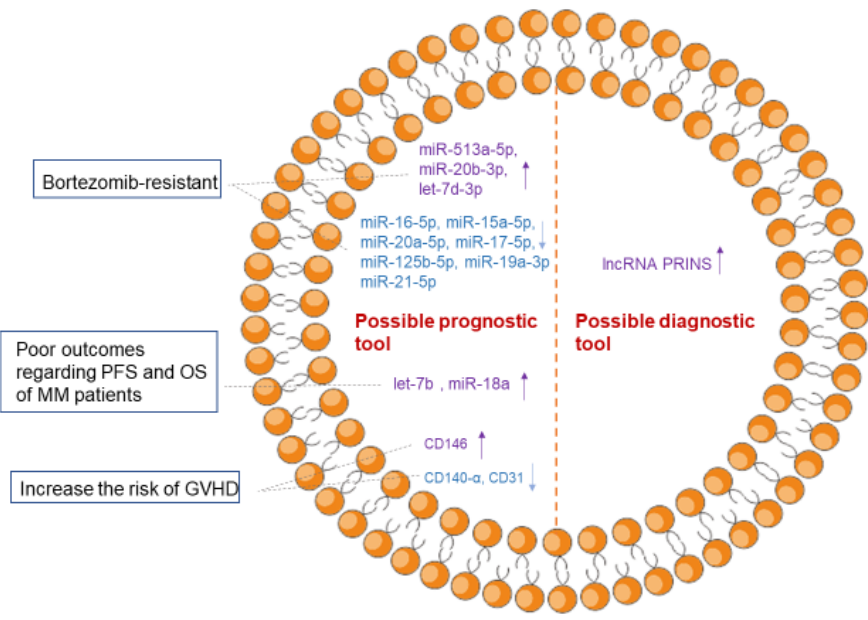
Figure 4. The potential of exosomes in the diagnosis and prognosis of MM. Exosomes may be used as a prognostic tool in MM due to their potential for the early prediction of drug resistance, the outcomes regarding PFS and OS and the risk of GVHD after ASCT. In addition, exosomes may be used as a diagnostic tool for MM owing to the abnormal expression of “cargos” in exosomes. CD146, melanoma cell adhesion molecule 1; CD140-α, platelet-derived growth factor receptor; CD31, platelet endothelial cell adhesion molecule; PFS, progression-free survival; OS, overall survival; GVHD, graft-versus-host disease; ASCT, allogeneic stem cell